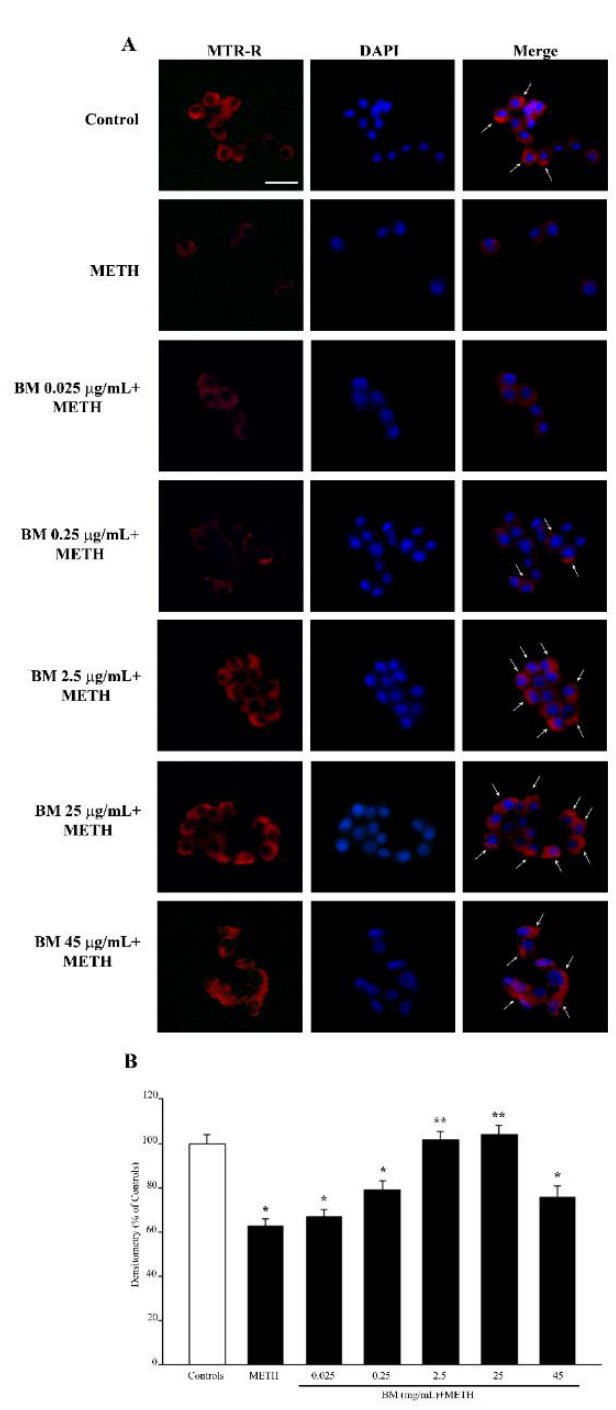
Figure 10. MitoTracker Red (MTR-R) fluorescence after combined treatments with BM and METH. ( A ) Representative pictures of MTR-R fluorescence show that BM counteracts the reduction in MTR-R fluorescence induced by METH. Arrows indicate intense MTR-R fluorescence. Cell nuclei are stained in blue with DAPI. ( B ) The graph reports the MTR-R fluorescence intensity. Note that protective effects of BM against METH-induced mitochondrial toxicity are evident at the doses of 2.5 µ g/mL and 25 µ g/mL. Values are given as mean percentage ± S.E.M. of optical density (assuming controls as 100%) from three independent experiments. * p < 0.05 compared with controls; ** p < 0.05 compared with METH. Scale bar = 17 µ